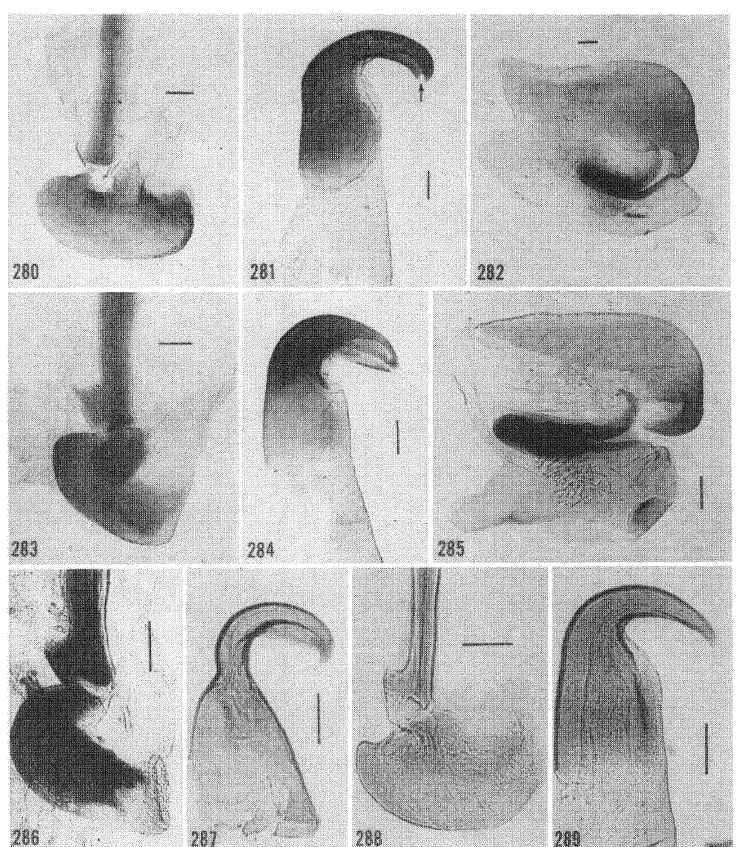
Figures 280-289. Male genital phallomeres o Trichoblatta spp. 280-282. (103 MCZ). T. nigra (from shown in Fig. 269). 283-285. (8 BMNH). T. guerini (from. $ shown in Fig. 266). 286-287. (987 L). T. ygmaea (from $ shown in Fig. 263). 288-289. (984 L). T. sericea (from $ shown in Fig. 265). (scale --0.1